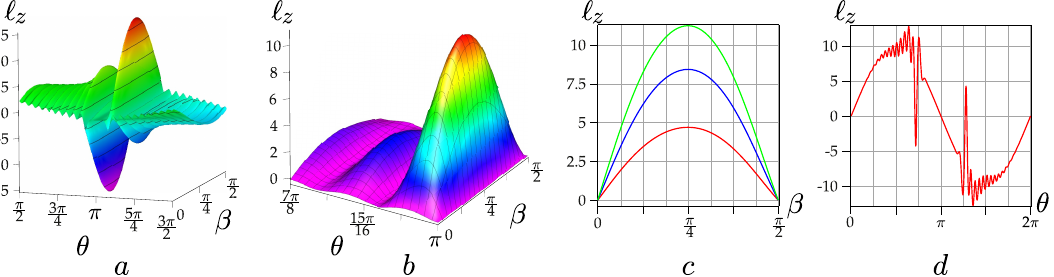
Figure 4. ( a , b ) 3D intensity distributions of the OAM (cid:96) z ( 1, θ , β ) for the asLG beam states ( a ) ( n , (cid:96) ) = ( 20,5 ) , ( b ) ( 20,1 ) , ( c ) the OAM (cid:96) z ( β ) : red curve— ( n , (cid:96) ) = ( 8,1 ) for θ = π − 0.1, blue curve— ( n , (cid:96) ) = ( 15,1 ) for θ = π − 0.075, green curve— ( n , (cid:96) ) = ( 20,1 ) for θ = π − 0.05 that correspond to max (cid:96) z ( β ) and ( d ) ( n , (cid:96) ) = ( 15,20 ) , β = π /4.